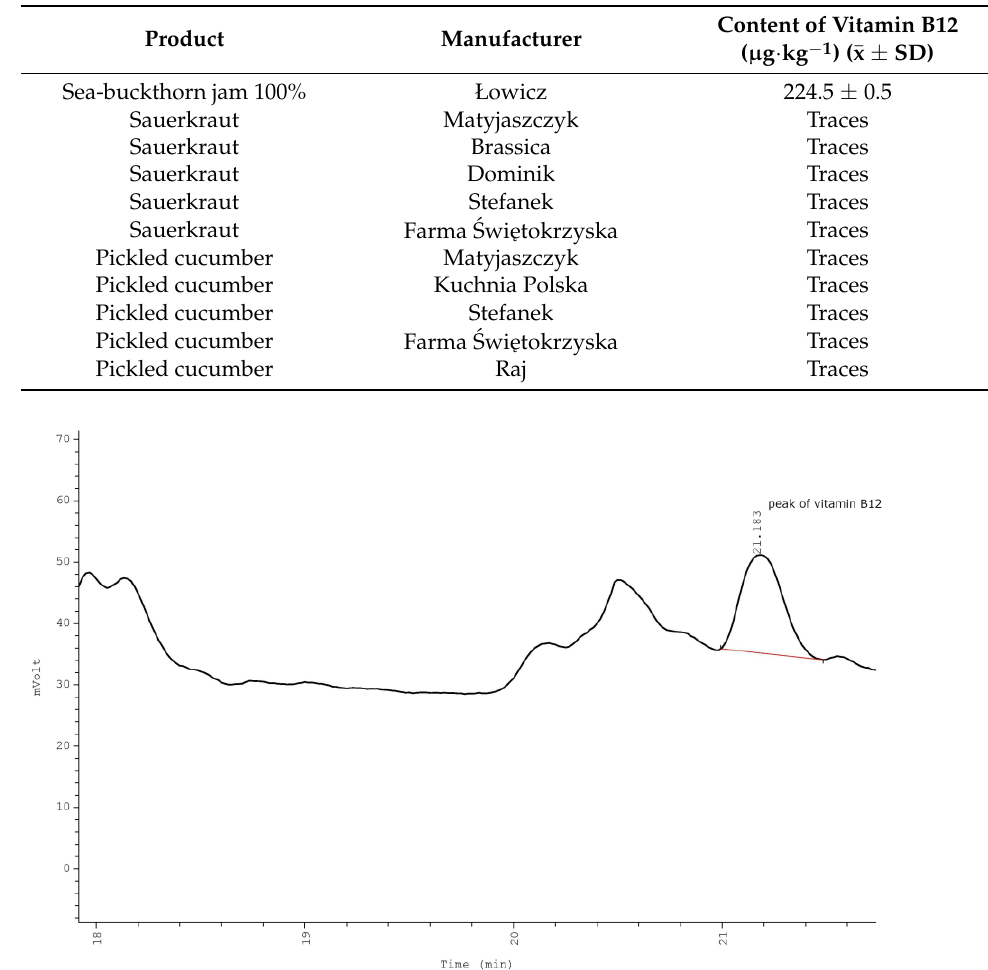
Figure 2. HPLC chromatogram obtained after the analysis of the sea-buckthorn jam sample. In solid samples of sauerkraut of all manufacturers, only trace amounts of vitamin B12 were detected. The same results were obtained by the analysis of cucumber solid samples. In the next stage of the study, liquid samples of pickled cucumber and beetroot brines, as well as sauerkraut and parsley juices, were analyzed. Only the latter samples were found to contain significant amounts of vitamin B12, up to 50.5 µg·L −1 , while other samples were found to contain only trace amounts of vitamin B12 (Table 2, Figure 3). Table 2. Content of cyanocobalamin in liquid samples of fermented vegetable products. Product